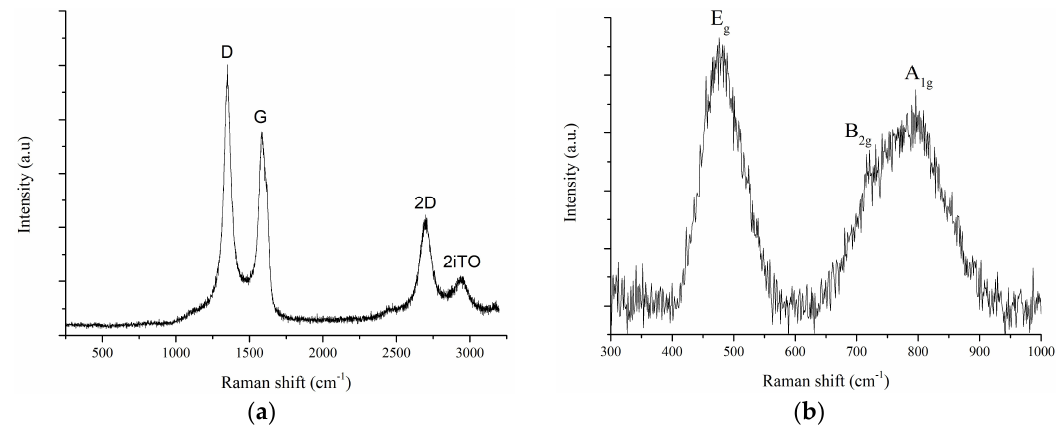
Figure 1. Typical Raman spectrum of the multi-wall carbon nanotubes (MWCNTs) used ( a ). Detailed Raman spectrum recorded in the 300–1000 cm − 1 region corresponding to peaks attributed to the presence iridium oxide nanoparticles in IrO x -MWCNT samples ( b ).